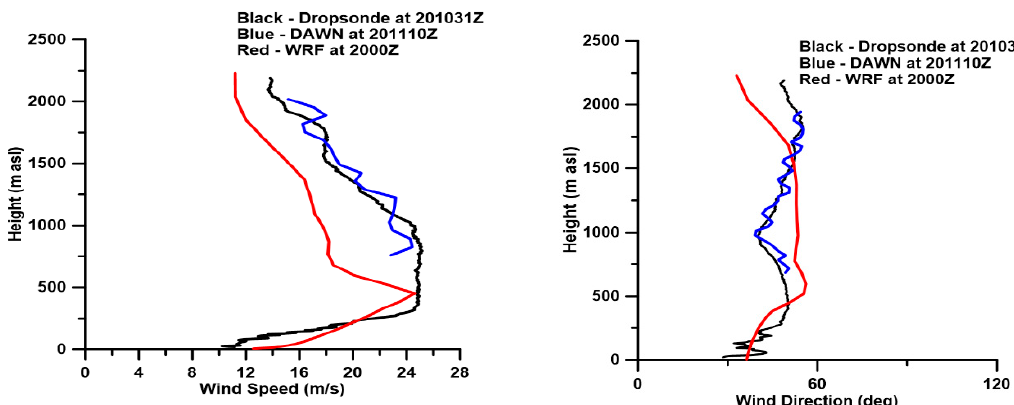
Figure 10. DAWN, dropsonde and model profiles of wind speed ( left ) and wind direction ( right ) further off-shore around 2010Z on 21 May 2015.